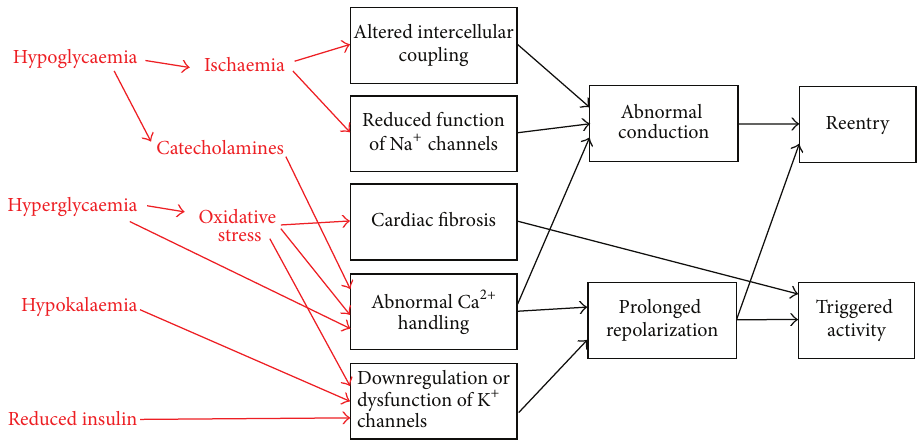
Figure 1: Both conduction and repolarization abnormalities promote arrhythmogenesis in diabetes.